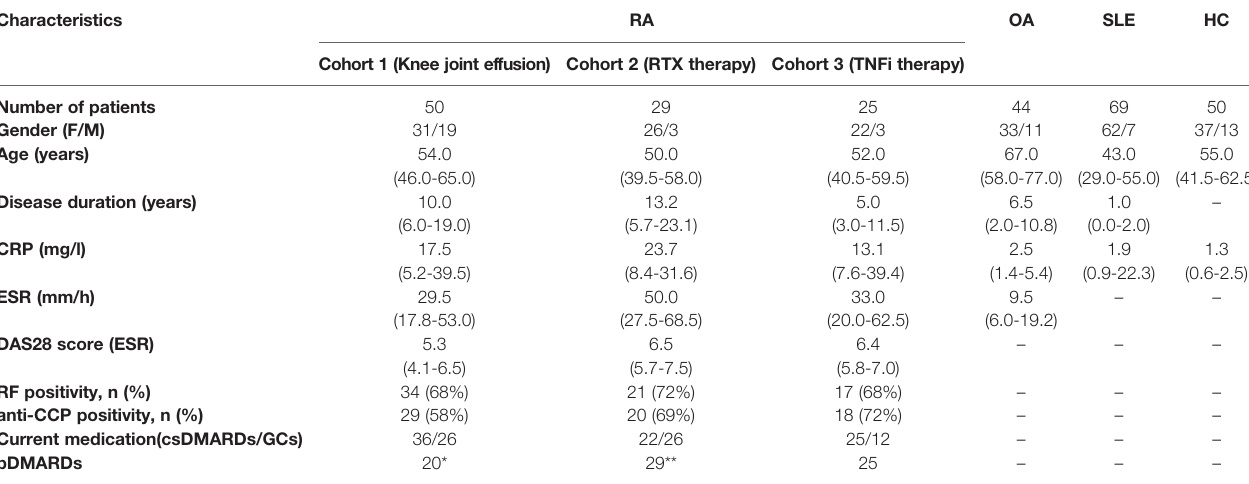
TABLE 1 | Characteristics of patients with rheumatoid arthritis (RA), osteoarthritis (OA), systemic lupus erythematosus (SLE) and healthy controls (HC).